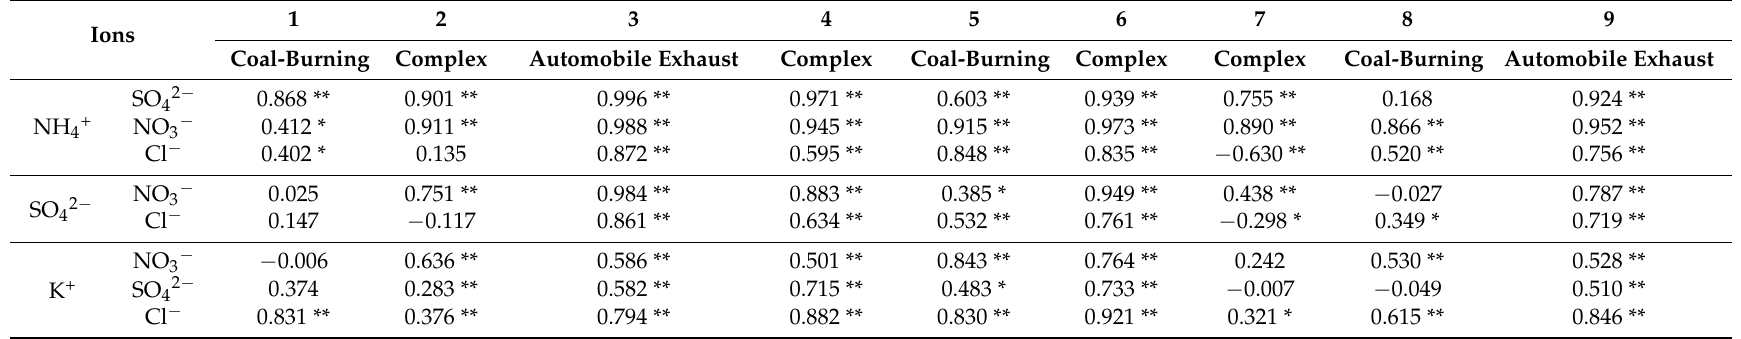
Table 3. Correlation coefficients (R 2 ) of major ions obtained for various pollution episodes. Asterisks denote a significant difference at a level of p < 0.05 (**) and p < 0.10 (*),